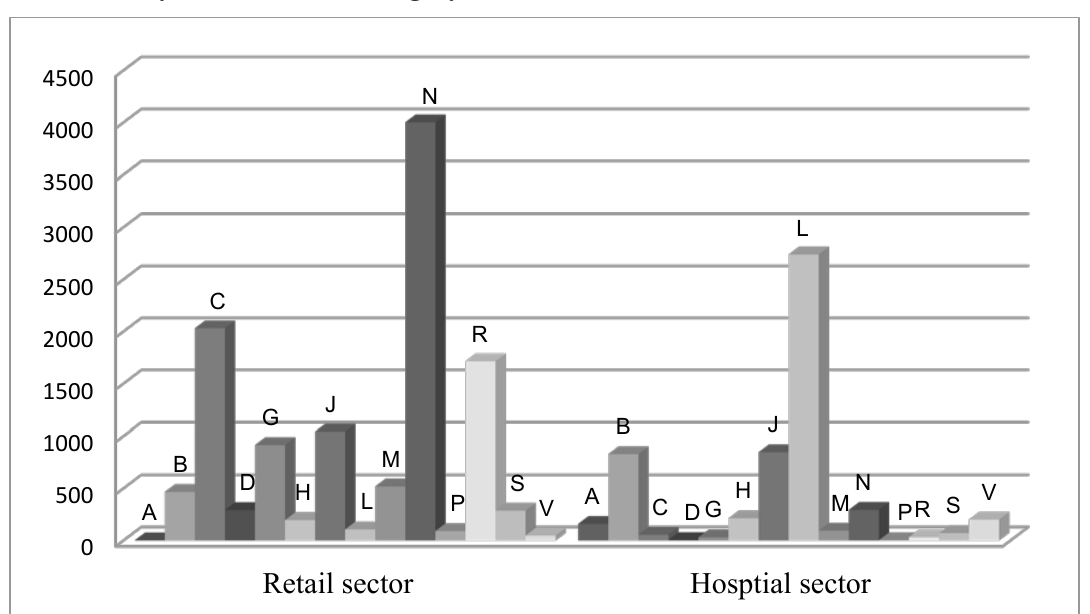
Figure 2: Pharmaceutical sales in millions of DKK in the retail and hospital sector by main anatomic category in